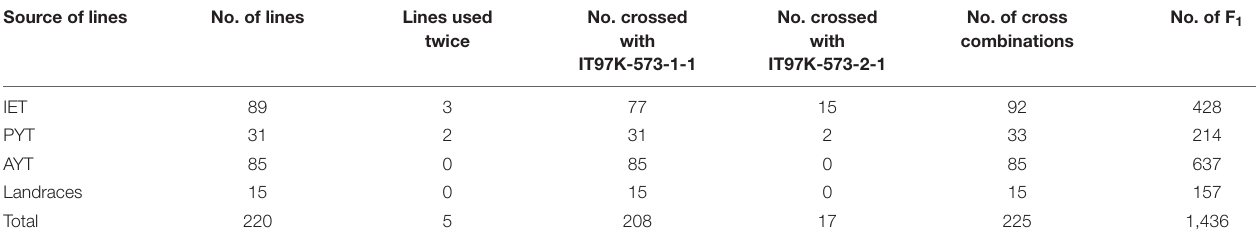
TABLE 1 | Source of parental lines and the statistics of the crossing structure. Source of lines No. of lines Lines used